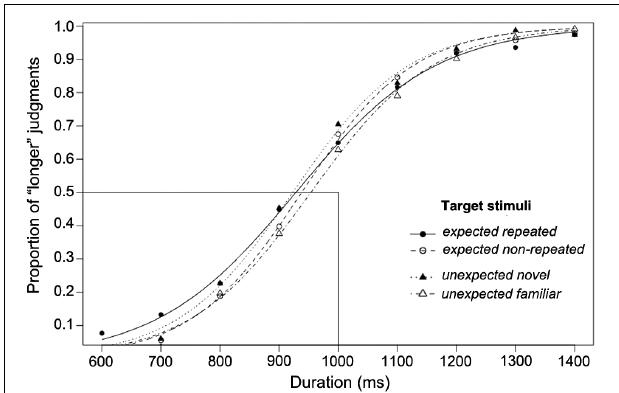
FIGURE 4 | The proportion of “longer” judgments made for each duration and psychometric curves fitted for expected and unexpected target stimulus conditions over 26 participants using a long standard duration (1,000 ms; Experiment 2).